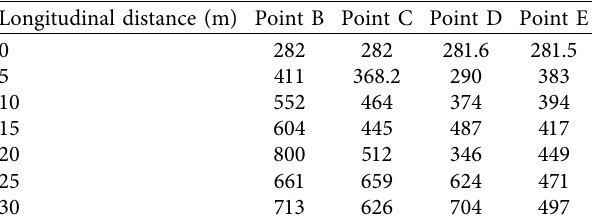
Table 2: The stable temperature inside of the tunnel lining structure after 200 iterations (K).